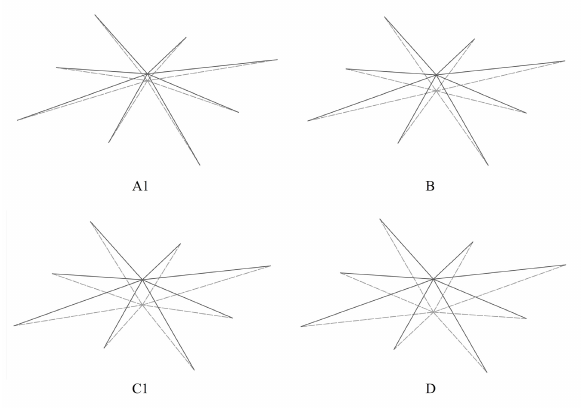
Figure 5: Eight-member structure displacements - λ max = 25.2